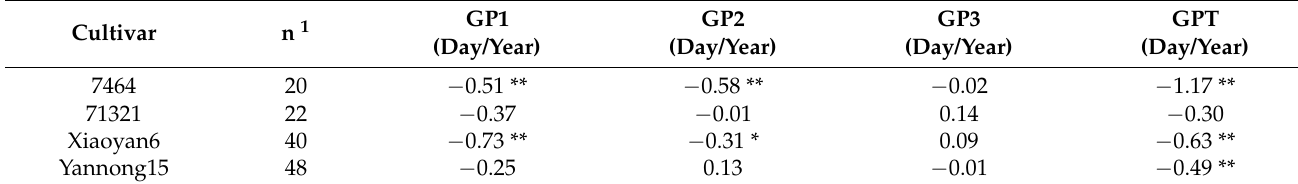
Figure 2. Length of winter wheat growth periods (GP) as impacted by climate change. ( A ) displays the variations in GP with different cultivars, and ( B ) displays the variations in GP at different stations of one cultivar (Yannong15). Blue, green, yellow and red indicate the GP from sowing to jointing (GP1), from jointing to anthesis (GP2), from anthesis to maturity (GP3), and from sowing to maturity (GPT), respectively. Lines extend from 5th to 95th percentile of length, boxes extend from 25th and 75th percentile, and the middle vertical line within each box indicates the median length. Table 4. Temporal trends of length of growth periods during the different growth periods of winter wheat for four different